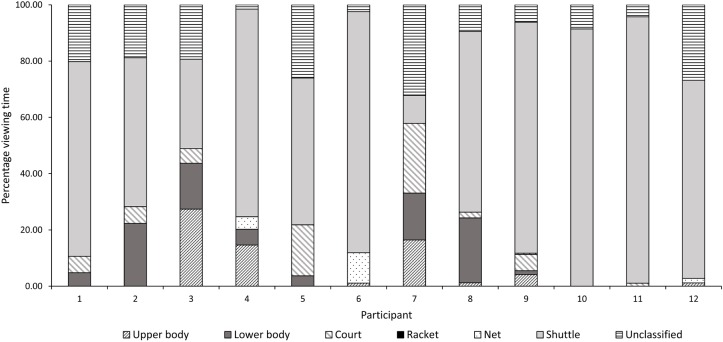
Mean and standard deviation of time spent viewing each AOI by individual participants (less skilled) across conditions as a percentage of total viewing time.